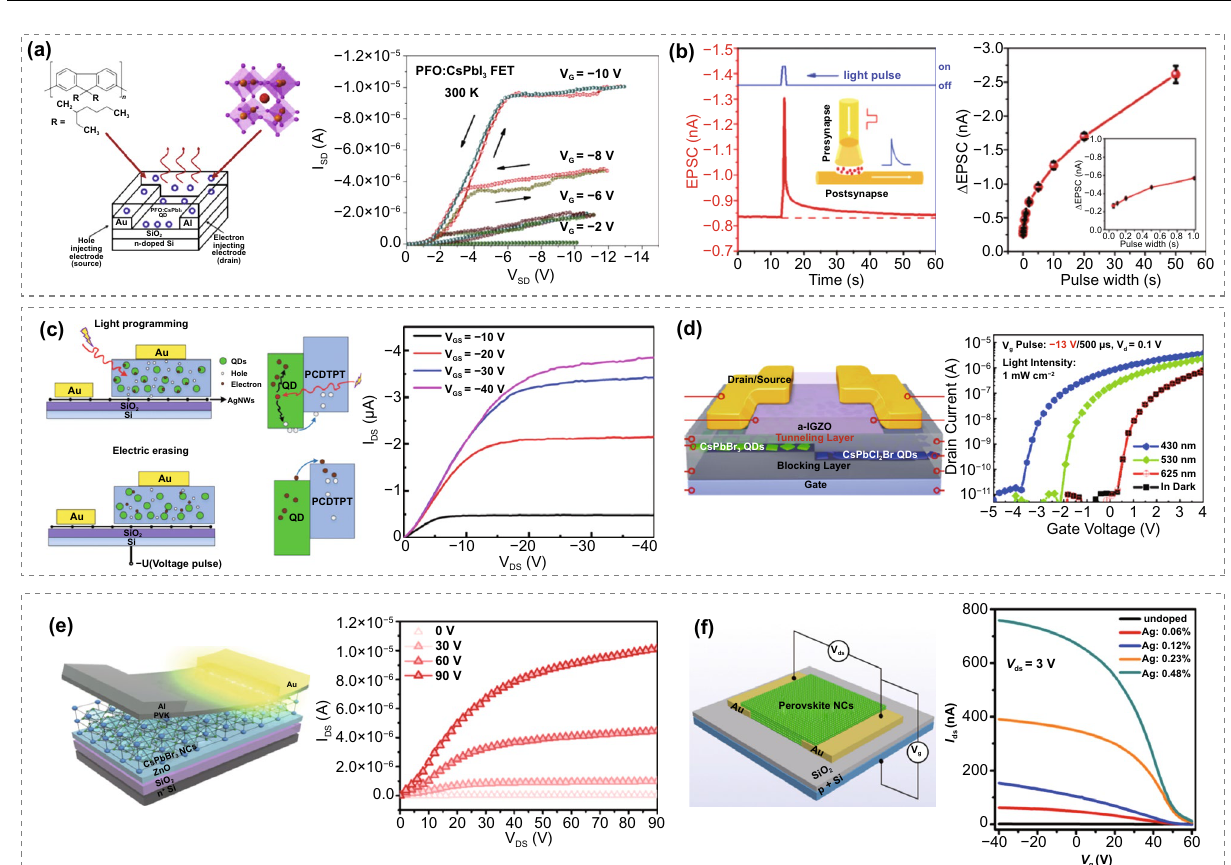
Fig. 5 a The structure and output curves of the PFO:CsPbI 3 FET. Adapted with permission from Ref. [153]. Copyright 2017, Elsevier Pub- lishing. b Schematic diagram demonstrating the mechanism of CsPbBr 3 QD-based light simulated synaptic FET and the measurement results. Adapted with permission from Ref. [157]. Copyright 2019, Wiley–VCH. c Operating mechanism of the photonic memory device under light programming and electric erasing processes, along with its output characteristic curves. Adapted with permission from Ref. [158]. Copyright 2020, Royal Society of Chemistry d Schematic diagram of the stepped inorganic perovskite QDs-based floating-gate transistor structure and its transfer curves under light illumination with different wavelengths. Adapted with permission from Ref. [162]. Copyright 2022, American Chem- istry Society. e Schematic diagram of the CsPbBr 3 QD-based light-emitting field-effect transistor and its transfer curves. Adapted with permis- sion from Ref. [163]. Copyright 2020, American Chemistry Society. f Schematic diagram of Ag + -doped CsPbBr 3 QDs FET device structure and its output characteristics. Adapted with permission from Ref. [164]. Copyright 2019, American Chemistry